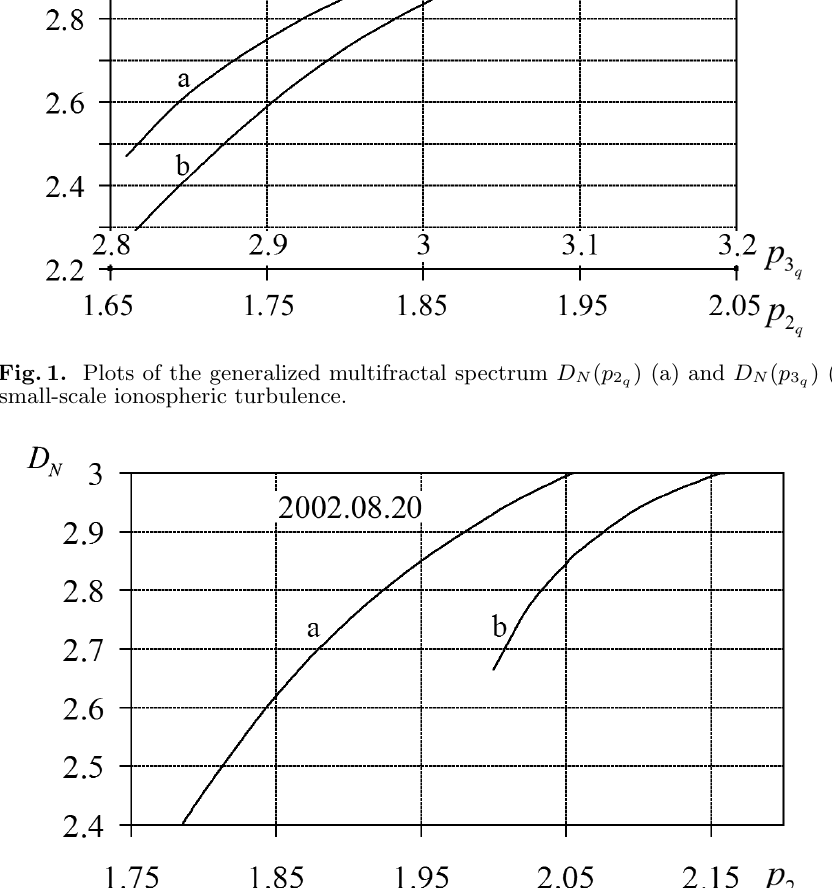
Fig. 2. Plots of the multifractal spectra of small-scale ionospheric turbulence (receiver at the Arya